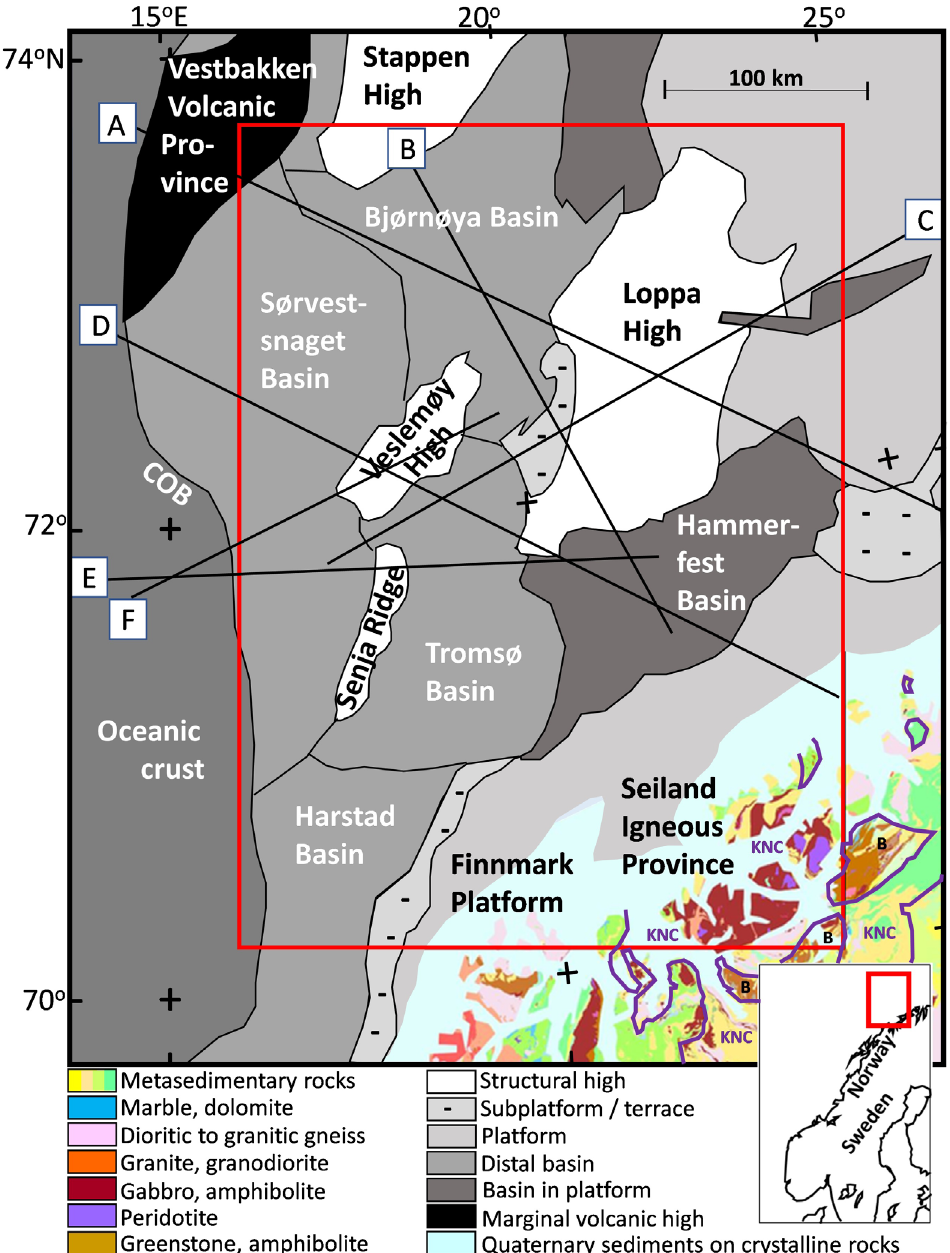
Figure 1. Offshore structural elements at base Cretaceous level (Norwegian Petroleum Directorate: www.factmaps.npd. no/factmaps/3_0/ visited 11.01.2022, based on Gabrielsen et al., 1984, 1990) and onshore geological map (Geological Survey of Norway: www.ngu.no/emne/kart-pa-nett “Berggrunn 1:250,000 vektor (Gammel)” visited 11.01.2022) with B – parautochthonous basement, KNC – Kalak Nappe Complex, (Corfu et al., 2014); superimposed are the seismic profiles: (A) – PETROBAR-07 (Clark et al., 2013), (B) – NBR07-232948 (Gernigon et al., 2014), (C) – OBS profile 1 (Aarseth, 2018), (D) – IKU-C (Ritzmann & Faleide, 2007), (E) – WBS-4/7142 (Breivik et al., 1999; Faleide et al., 2008), (F) – OBS profile A (Mjelde et al., 2002). Red box shows the location of the modelled area. Projection: UTM33, datum: